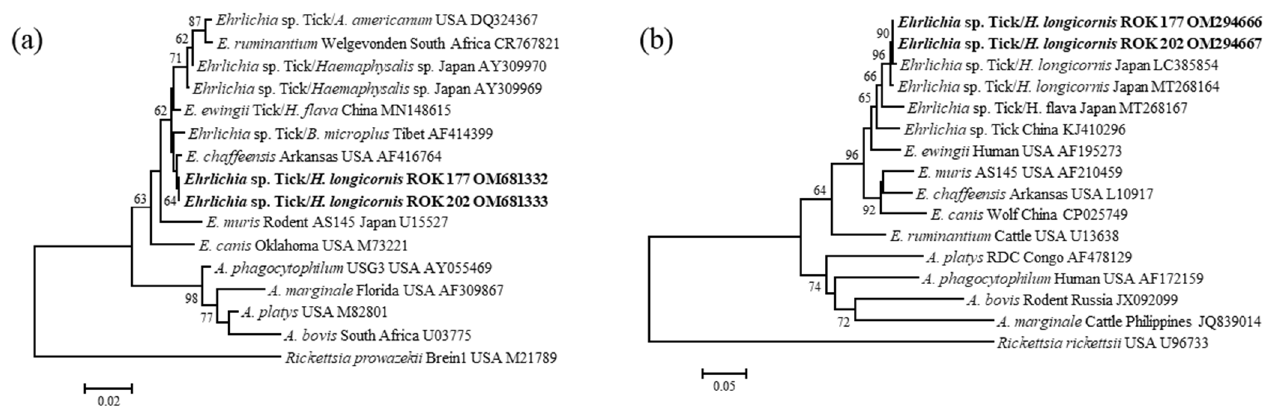
Figure 2. Phylogenetic relationships for Ehrlichia sp., based on the partial nucleotide sequence of ( a ) Ehrlichia 16S rRNA and ( b ) gro EL gene. The neighbor-joining method was used for constructing a phylogenetic tree. The numbers at the nodes represent the proportions of bootstrap values for the branch point. The two Ehrlichia sp.-positive sequences identified in this study are indicated in bold. Reference strains of Ehrlichia with the host, country of detection, and the National Center for Biotechnology Information accession numbers are also shown. Scale bars indicate sequence distances.